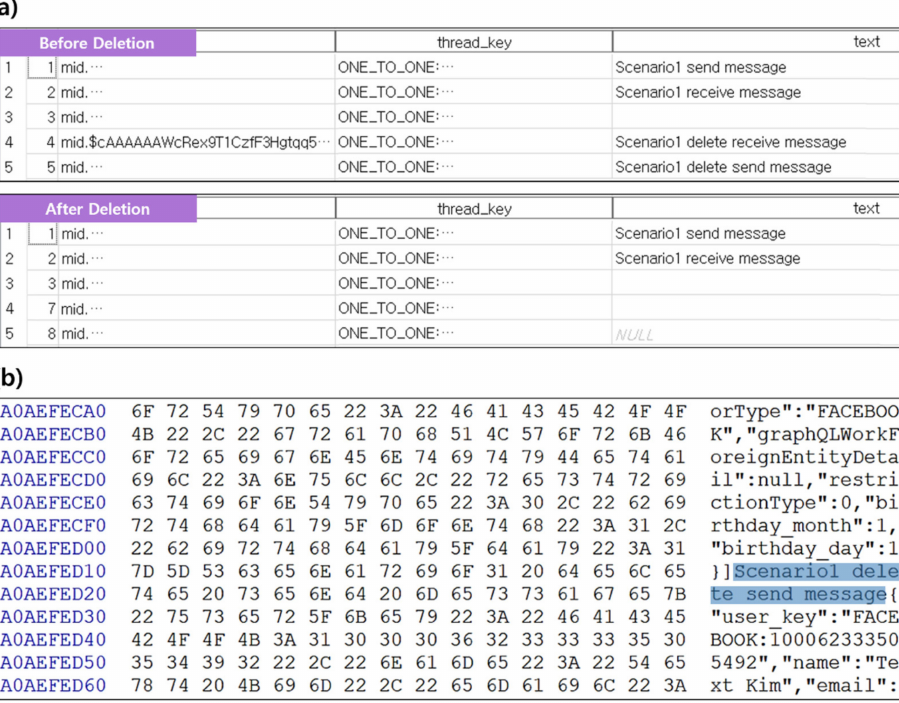
Figure 5. Analysis of db files and db-wal files before and after data deletion using scenario I ( a ) Comparison of threads_db2’s before and after app data deletion ( b ) Traces of deleted data remain- ing in